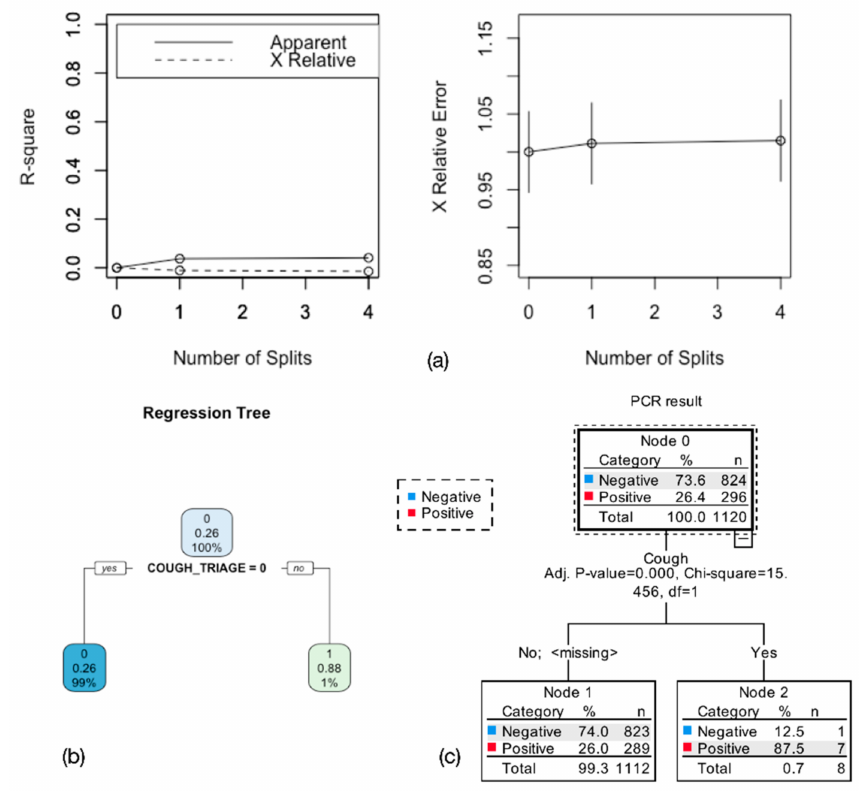
Figure 2. Regression tree for symptom variables (cough, fever, headache, dyspnea, myalgias, rhinor- rhea, diarrhea, thrombosis, neurological symptoms, arrhythmia, lethargy) and PCR test positivity. ( a ) shows the cross-validated error of the regression tree. Only one variable split the tree, indicating that 88% of women who tested positive had cough at triage ( b ). CHAID tree also had one split, and the terminal nodes indicate that cough was present in 88% of women who tested positive, whereas only 26% of those who tested positive did not have cough ( c